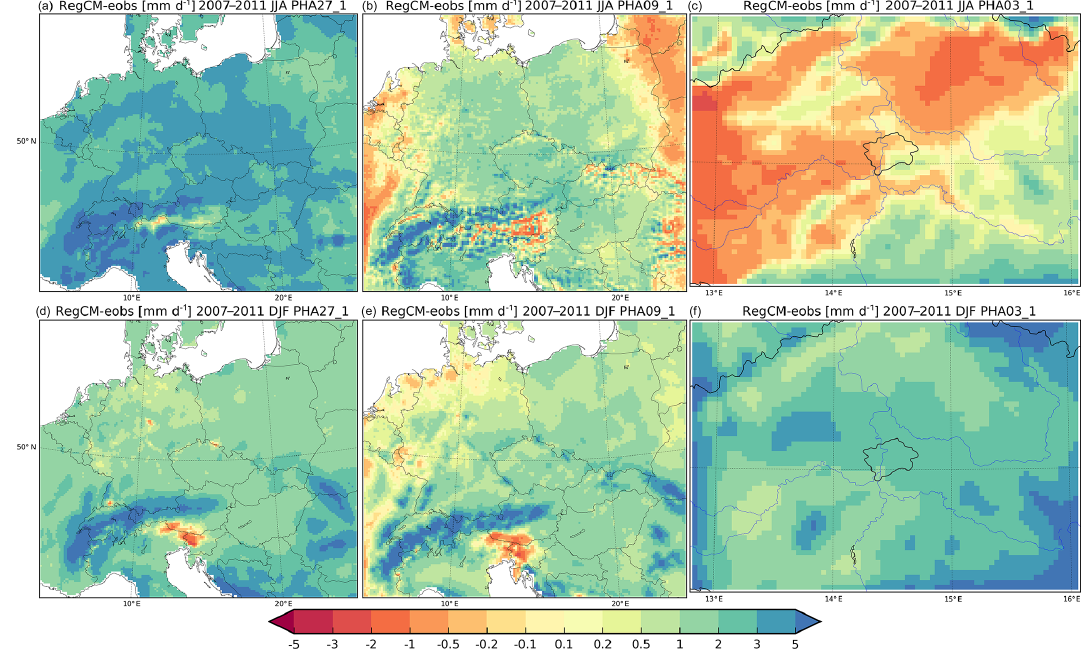
Figure 2. The difference between RegCM model precipitation and E-OBS data for 2007–2011 JJA (a, b, c) and DJF (d, e, f) for the 27, 9 and 3km domains (columns) in mmd − 1 . Note that the 27km domain is cropped to show only the part corresponding to the 9km domain. For the right panels, the administrative boundary of Prague is indicated